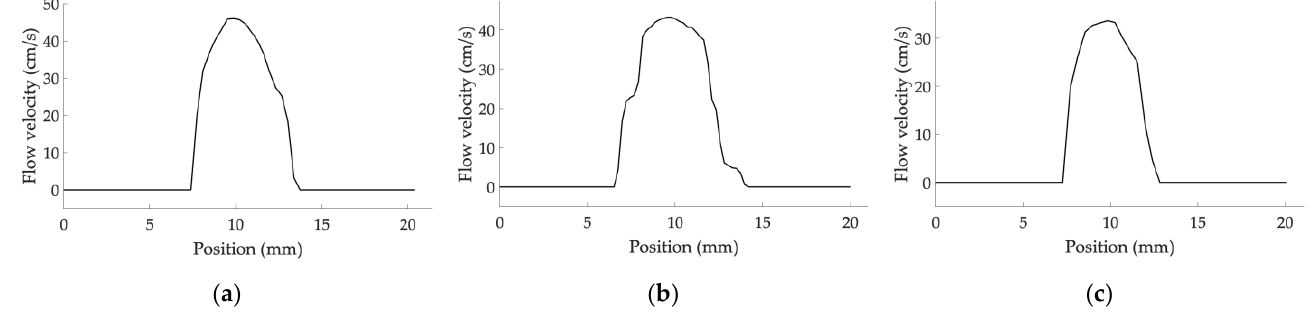
Figure 6. Ninety-degree rotated segments automatically drawn on the i -th average image for ( a ) system one, ( b ) system two and ( c ) system three equipped with convex array probes in configuration B at 7.0 mL·s −1 .